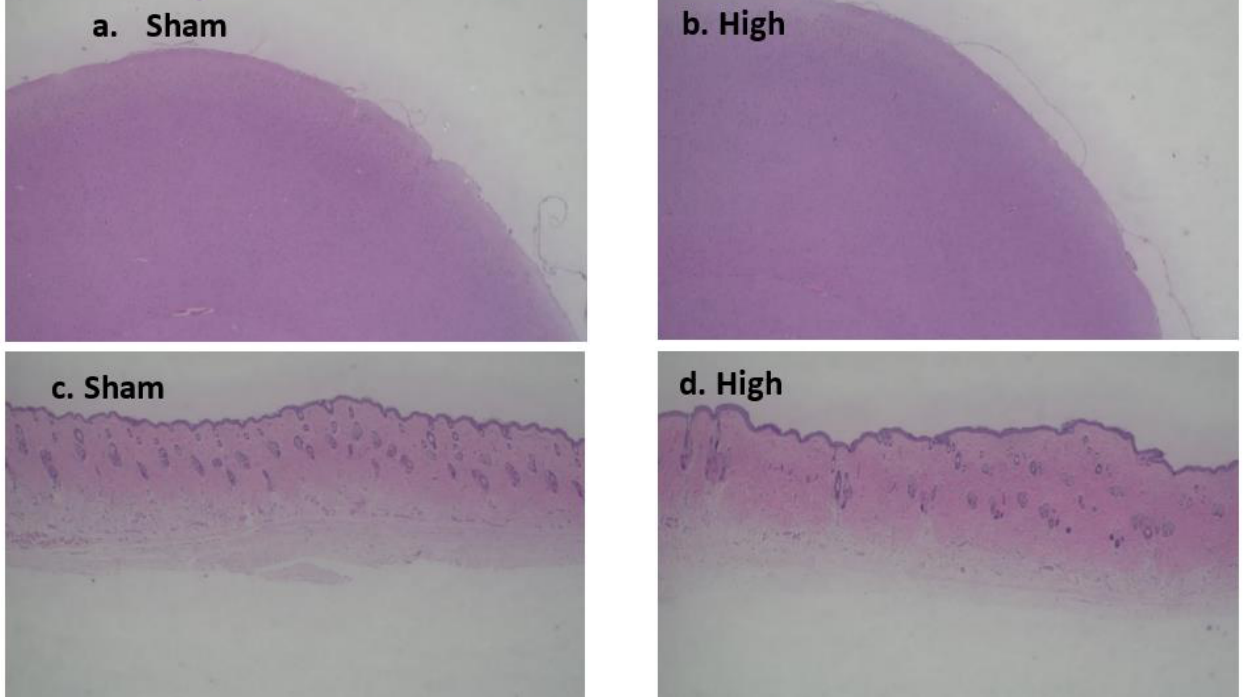
Figure 8. Effect of tDCS-iTBS on cortical tissue morphology (H&E staining) during long-term stimulation ( n = 16); ( a ) sham and ( b ) high-intensity stimulation (4.5 mA/cm 2 ) subgroups 40 µm coronal tissue section, while ( c ) sham and ( d ) high-intensity stimulation (4.5 mA/cm 2 ) magnified tissue section to represent stimulation efffect.